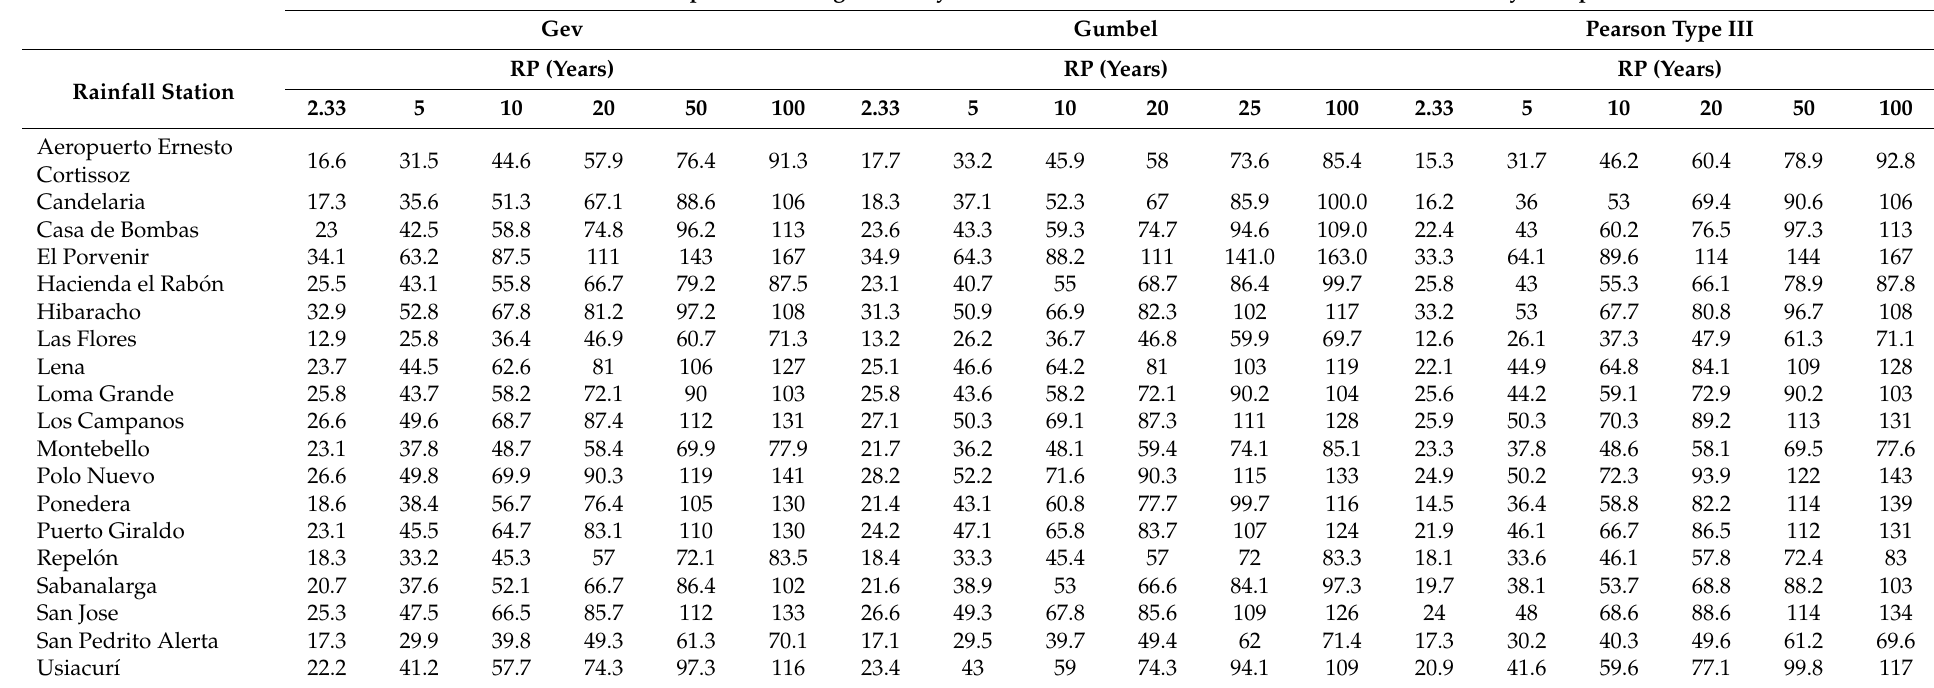
Table A2. Fit results of the cumulative precipitation during the 5 days prior to the occurrence of the annual maximum daily precipitation for different return periods using the different probability functions and fit of the moment